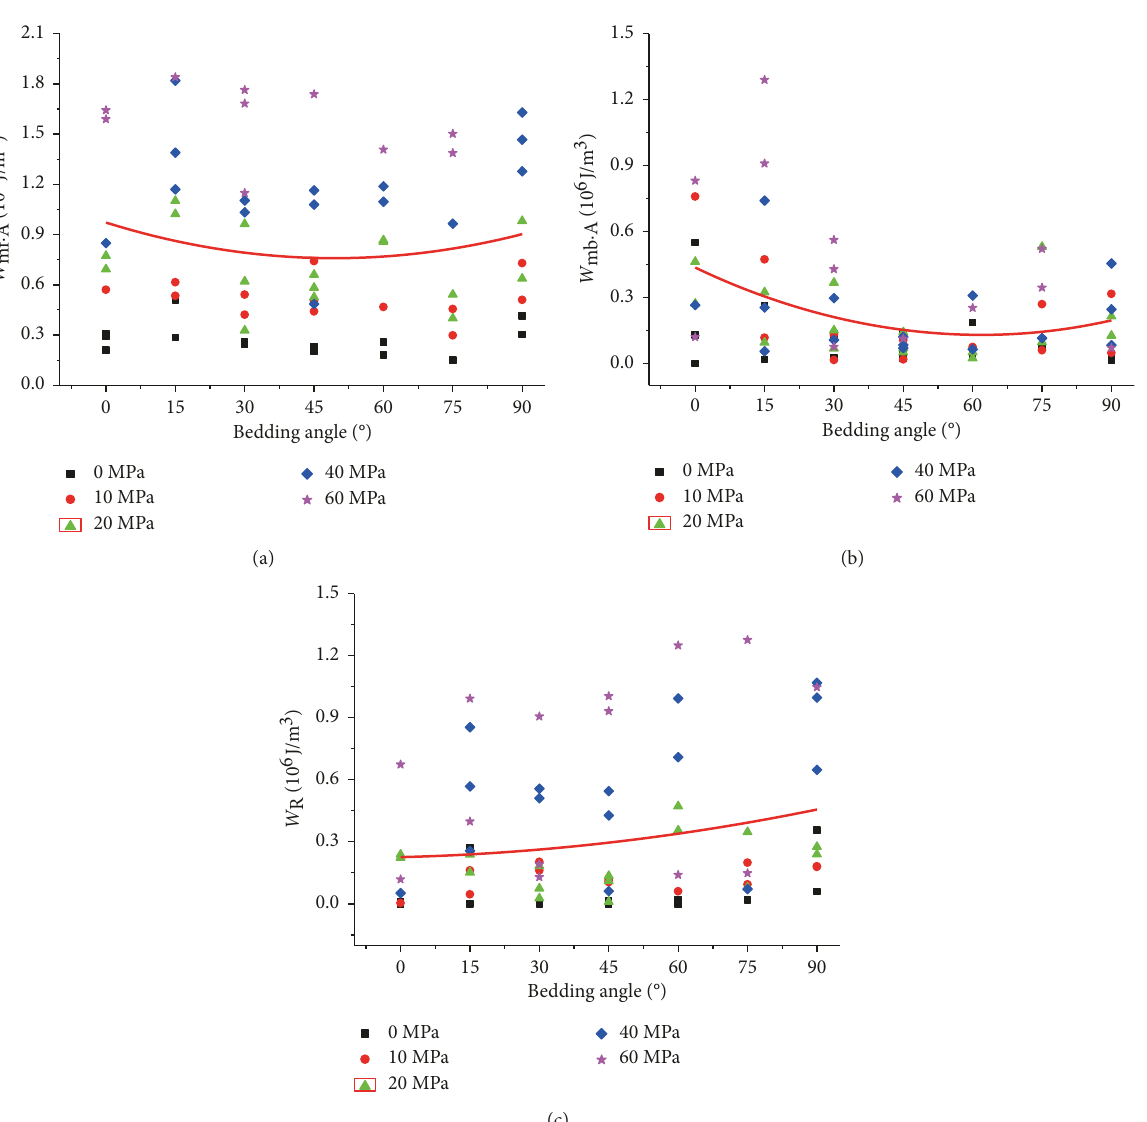
Figure 16: Relationship between energy, or work, related to brittleness and the bedding angle of slate. (a) The energy accumulated at the axial prepeak stage. (b) The work done by press at the axial postpeak stage. (c) The residual strain energy at the postpeak